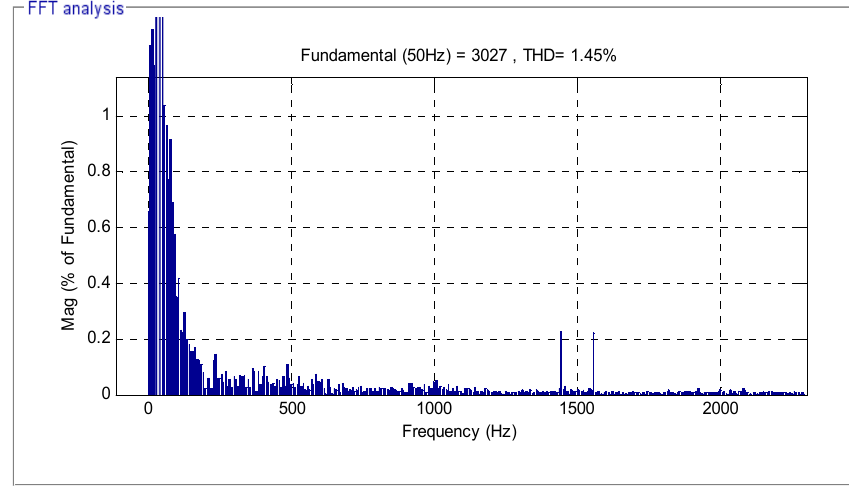
Figure 13. THD (direct FOC method).